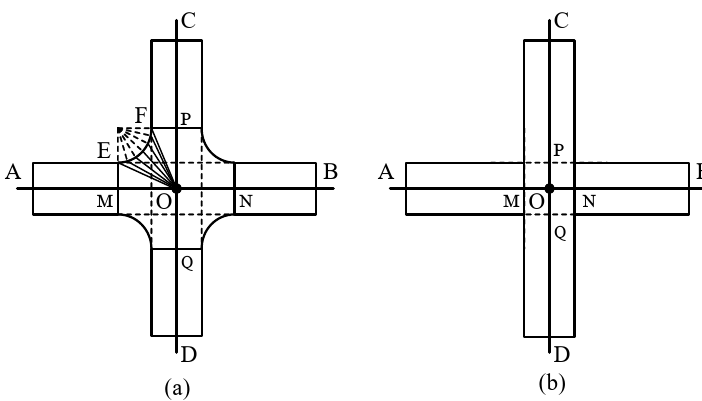
Figure 9. Four-way intersection modeling: ( a ) Grade intersection; ( b ) grade separation. At-grade Intersection Modeling